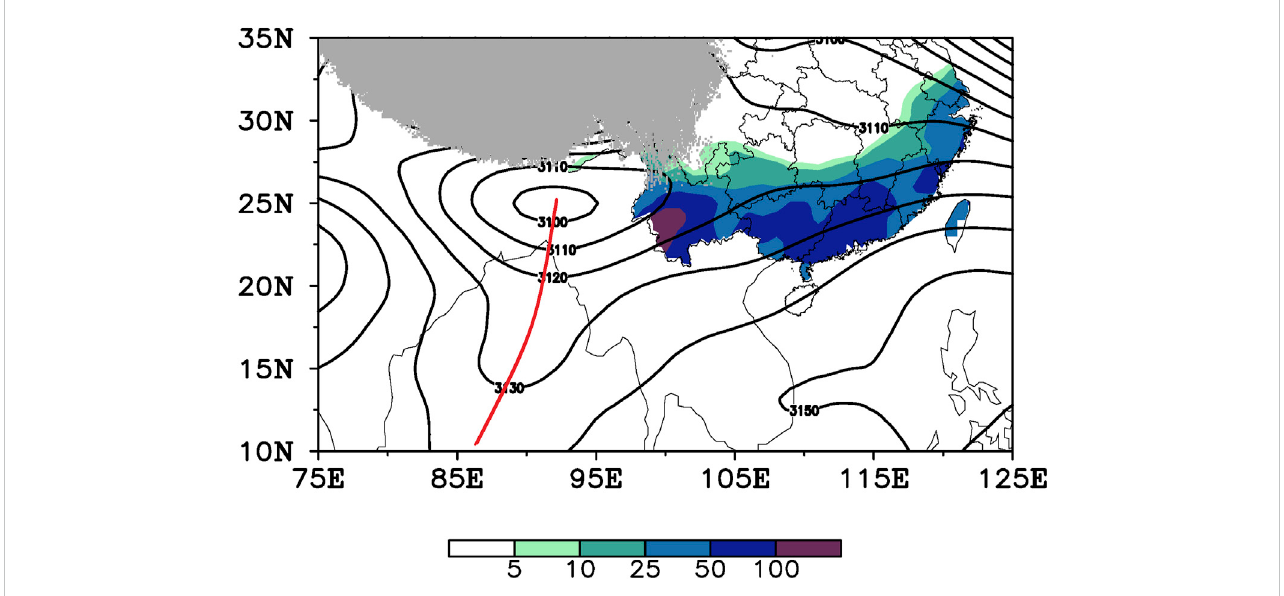
FIGURE 2 Averagegeopotentialheight fi eldat700 hPa(blackcontours,units:gpm)andthetotalaccumulated precipitation(shading;units:mm)fromJanuary8to 13, 2015. The red line shows the trough line of the SBT. The gray shading represents the shape of the Qinghai-Tibetan